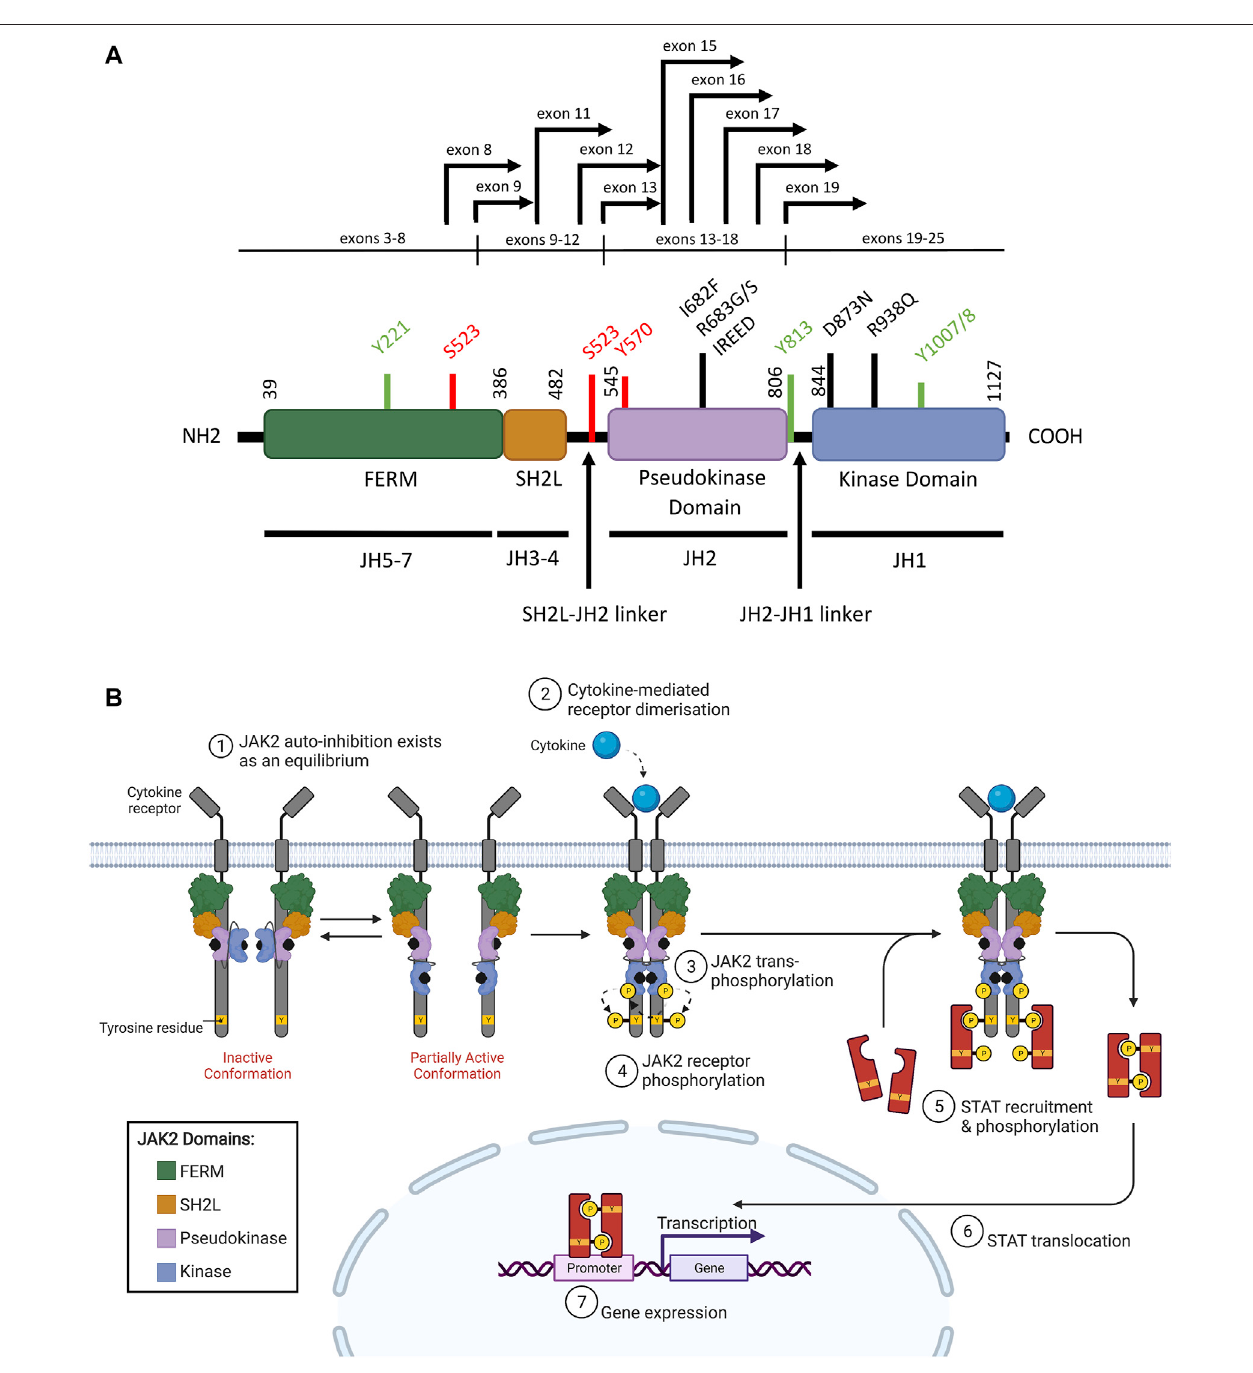
FIGURE 2 | WT JAK2 structure and function (A) Schematic representation of the JAK2 domain structure (NCBI reference sequence: NP_004963.1) encoded by thesevenJAKhomology(JH)domains.TheFERM(4.1protein,ezrin,radixin,moesin),SH2(Srchomology2)-like(SH2L),pseudokinase(JH2)andkinase(JH1)domains are represented by purple, red, light blue, and dark blue respectively. Key residues for phosphorylation for positive (green) or negative (red) regulation are shown. MutationscommonlyassociatedwithALL(blacklines)and JAK2 fusionbreakpoints(blackarrows)areindicated.AdaptedfromSilvennoinenandHubbard(2015b) (Silvennoinen and Hubbard, 2015a). (B) Schematic representation of JAK/STAT signaling pathway activation through JAK2. The JAK2 FERM and SH2L domains associatewiththecytoplasmicjuxtamembranemotifsofacytokinereceptor(grey)torecruitJAK2tothecellmembrane.ThefourdomainsofJAK2arepresented:FERM (green), SH2-like (orange), pseudokinase (JH2, purple), and kinase (JH1, blue). JAK2 is shown bound to ATP (black). The proposed model of JAK2 activation suggests that JAK2 exists in an equilibrium between inactive and partially active conformations. In the inactive conformation (left), the JAK2 kinase domain is inhibited by a JH2- mediated autoinhibitory interaction. In thepartiallyactive conformation(right), theJAK2 kinasedomain isreleased from the JH2-mediatedauto-inhibition and isavailable for some limited transphosphorylation. Cytokine (cyan) binding to their cognate receptor promotes receptor dimerisation, which facilitates JAK2 activation by